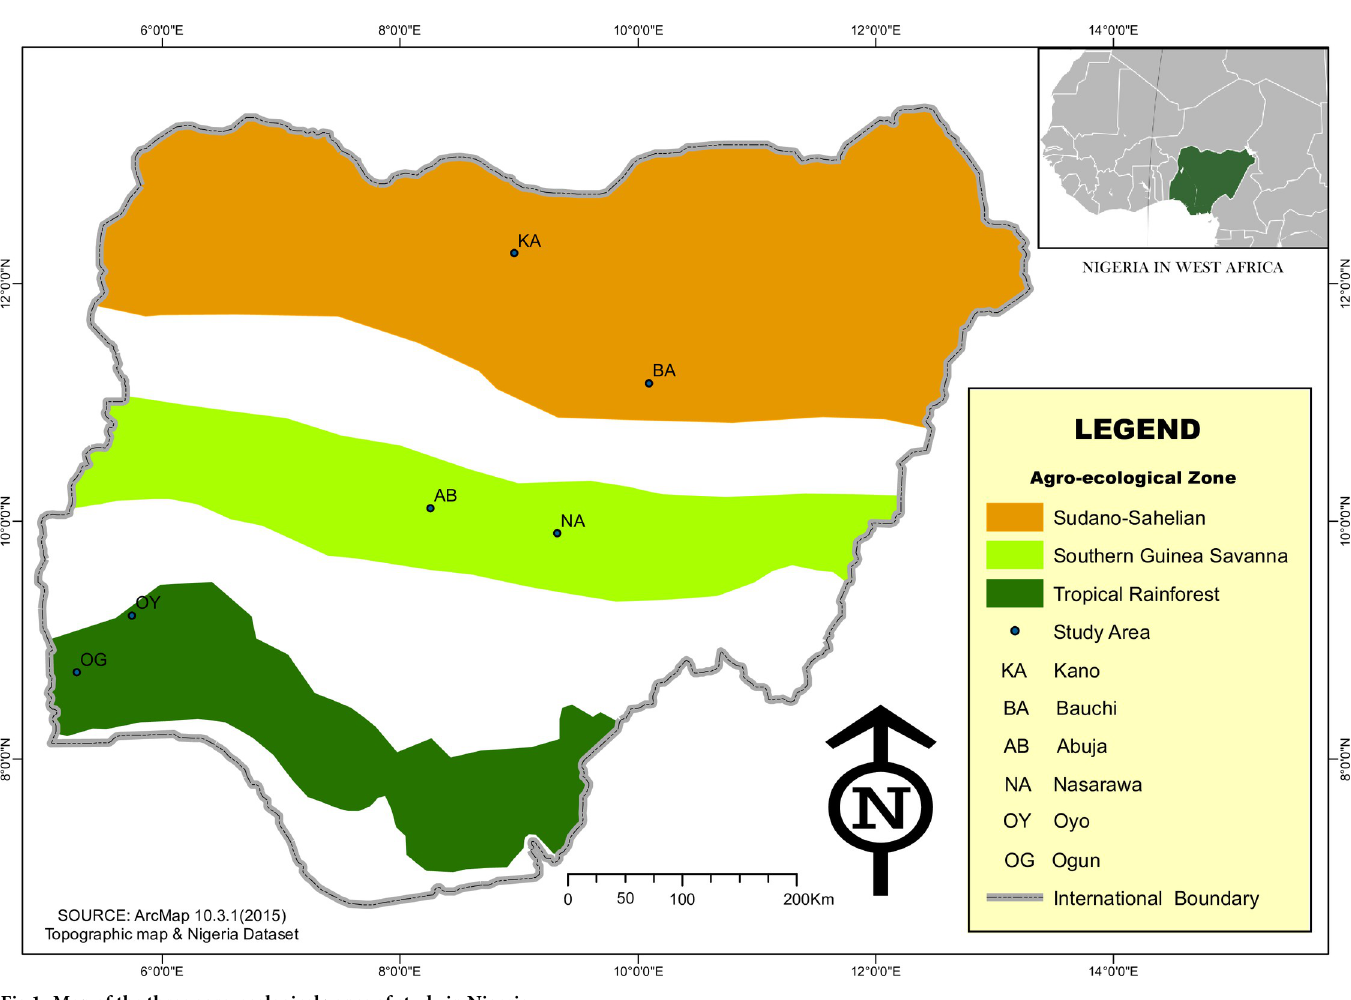
Fig 1. Map of the three agro-ecological zones of study in